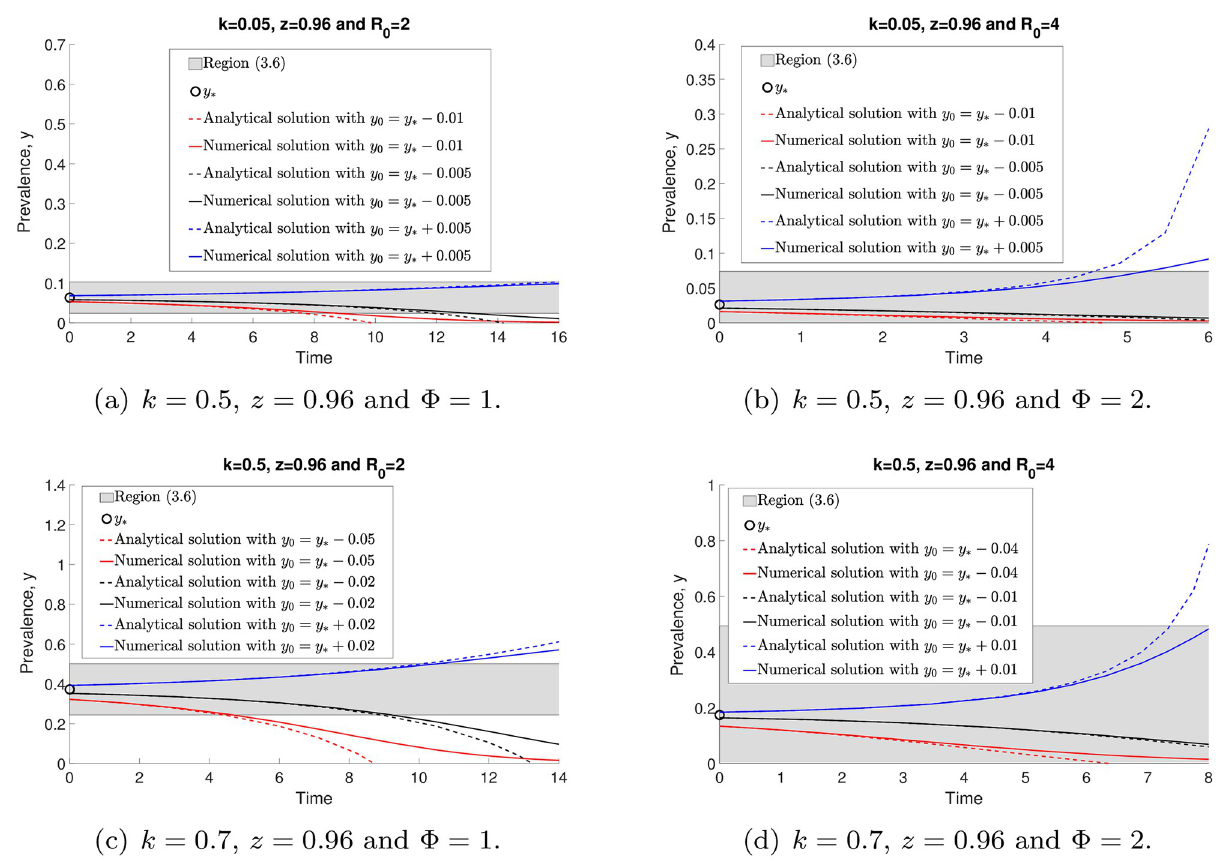
Fig 9. The comparisons of analytical (12) and numerical (5) solutions with arbitrary initial points around the unstable endemic equlibrium, y � .